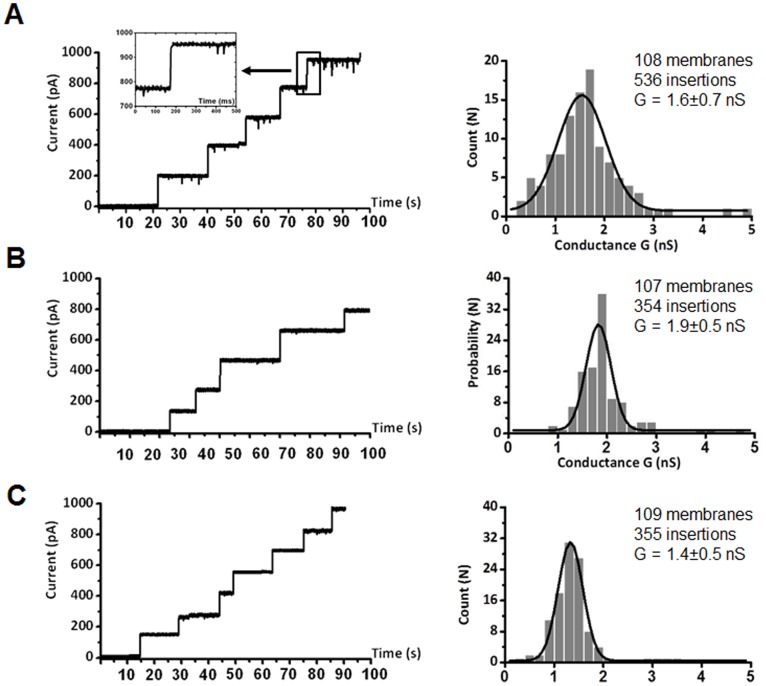
Ion current recordings obtained by the black lipid membrane (BLM) reconstitution technique.BLM measurements of successive insertions of BpsOmp38 trimers at a transmembrane potential of +100 mV. Lipid bilayers were formed across a 200-µM aperture by the ‘painting’ technique using 50 mg.mL−1 azolectin in n-hexane and bathed on either side in 1 M KCl. BpsOmp38 (1 µg.mL−1) was added on the cis side. (A) BpsOmp38WT, (B) BpsOmp38Y119A, and (C) BpsOmp38Y119F. Left panels are ion current traces acquired for 100 s. Fast insertion of one BpsOmp38WT channel, occurring within the millisecond time-resolution, was captured and shown as an inset. The traces represent multiple insertions of BpsOmp38 variants produced by applied membrane potentials of +100 mV. Right panels are histograms from the corresponding traces, giving the probability of a pore conductance (G) averaged over several hundred inserting channels as indicated. The black line represents a single Gaussian fit.